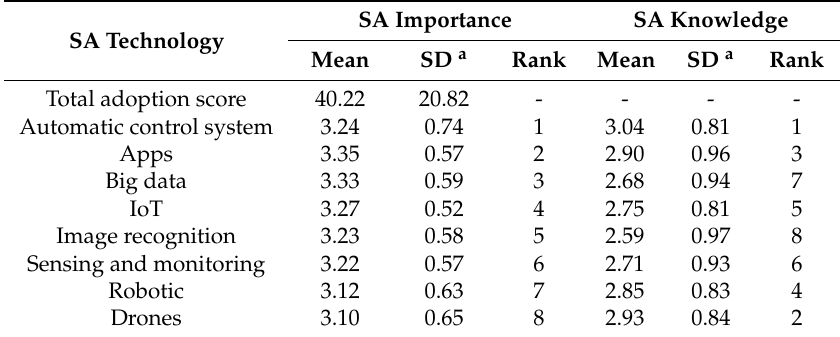
Note: a SD, standard deviation.